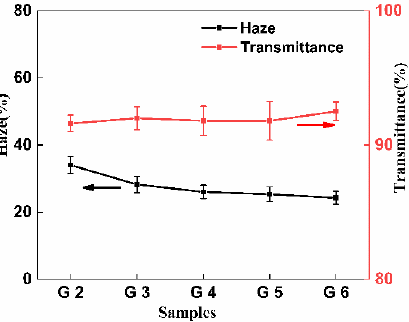
Figure 10. Effect of grafted monomers on the haze and transmittance of PLA/PPC and the PLA/PPC/PLA-g-GMA blends (G2: PLA/PPC; G3: PLA/PPC/PLA-g-GMA; G4: PLA/PPC/PLA-g- GMA/St; G5: PLA/PPC/PLA-g-GMA/AMS; G6: PLA/PPC/PLA-g-GMA/EP).